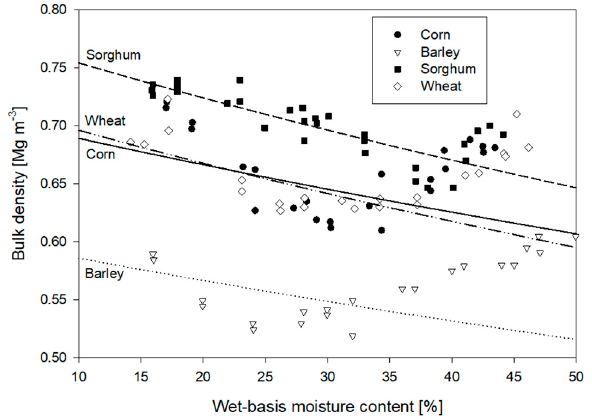
Figure 8. Measured bulk densities of four different cereals (digitized from [133]) compared to modeled results using Equations (7), (9) and (10) plotted as a function of wet-basis moisture content.